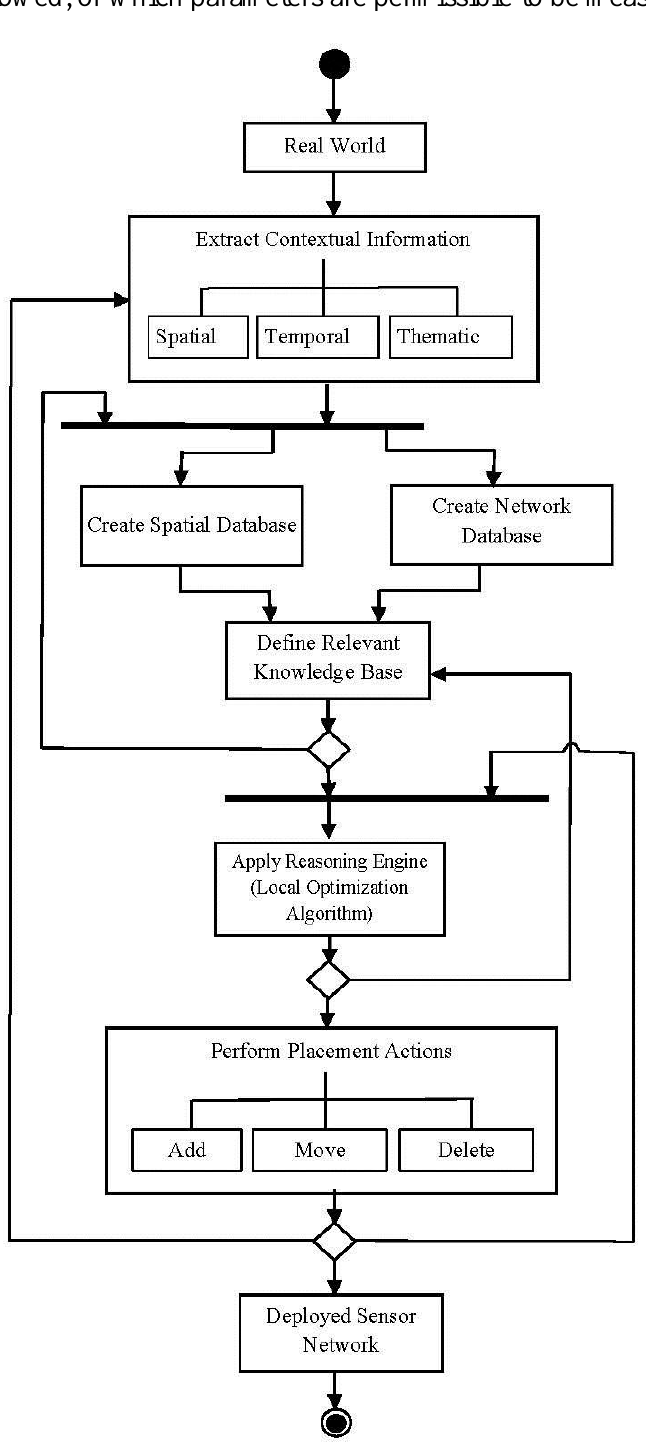
Figure 3. Context-aware sensor network deployment